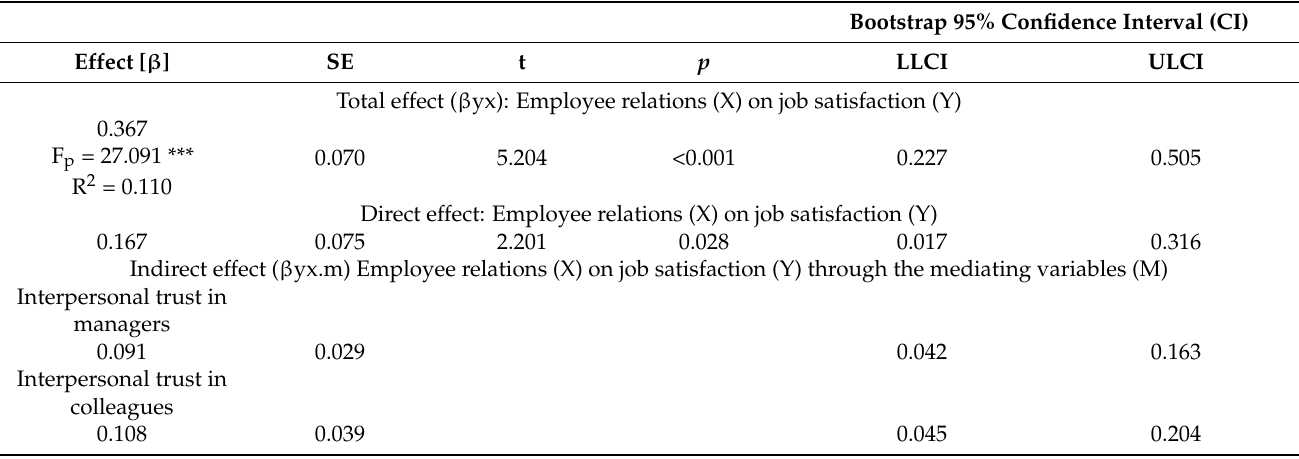
Table 7. Total, direct and indirect links between employee relations and job satisfaction through psychological trust in managers and trust in colleagues.